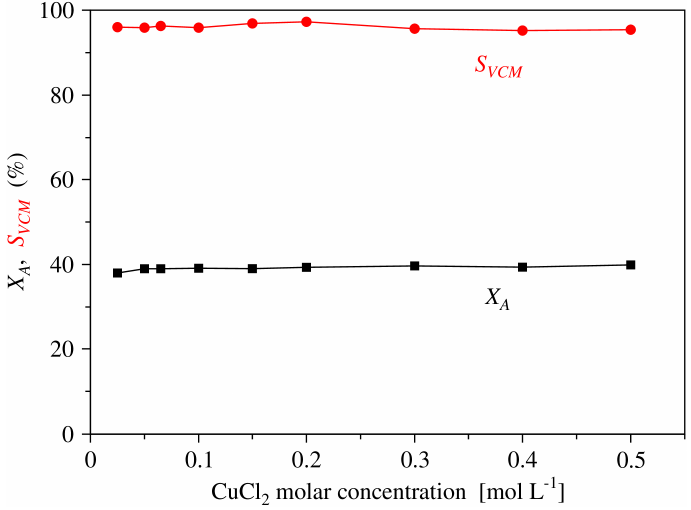
Figure 7. Acetylene conversion rate and VCM selectivity of CuCl 2 -[PrMIm]Cl, as a function of the concentration of CuCl 2 . Reaction conditions: temperature 140 ◦ C, C 2 H 2 GHSV = 370 h − 1 , V HCl :V C2H2 = 1.2.